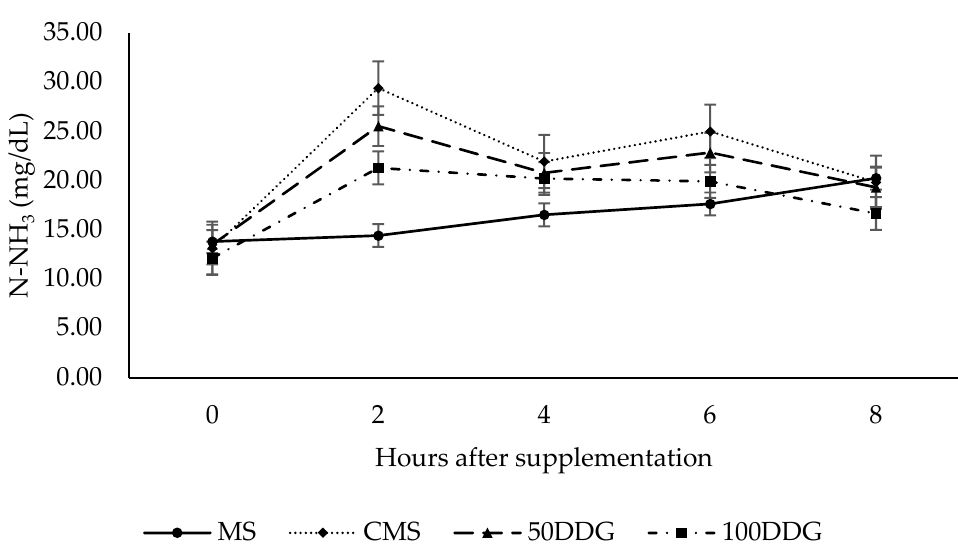
Figure 1. Ammoniacal nitrogen of cannulated young bulls fed with mineral supplementation (MS); conventional multiple supplement (energy/protein) with cottonseed meal and citrus pulp (CMS); supplement with 50% of CMS protein source replaced by DDG (50DDG); and supplement with 100% of CMS protein source replaced by DDG (100DDG), grazing Marandu grass during the wet season. The pH, VFA, and acetate:propionate values differed between collection times (Table 6). The pH decreased after 4 h, with the lowest value observed at 8 h. The concentration of acetate was highest at 0 and 2 h, and lowest at 8 h, whilst the lowest concentration of propionate (17.11 mmol/L) was observed at time 0. The concentration of butyrate was similar between times 0, 2, 4, and 6 h, ranging from 10.20 to 10.77 mmol/L, and the highest concentration was observed at 8 h (11.47 mmol L/). At time 0, the acetate:propionate ratio was highest (4.27 mmol/L), reaching an intermediate value at 2 h (3.97 mmol/L) and lower values were observed after 4 h. Table 6. Ruminal parameters of cannulated young bulls grazing Marandu grass during the wet season over an 8 h period after supplementation.